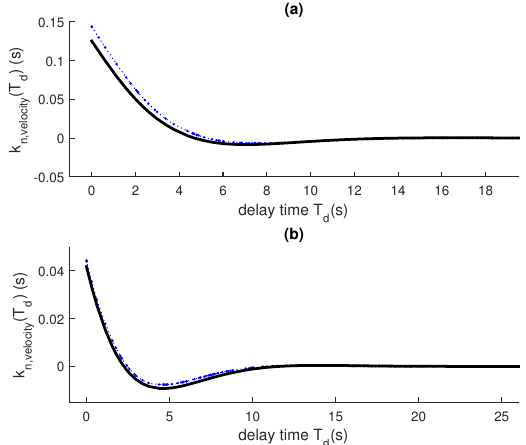
(cid:34) (cid:35) 0 0 , R = 1, 0 1